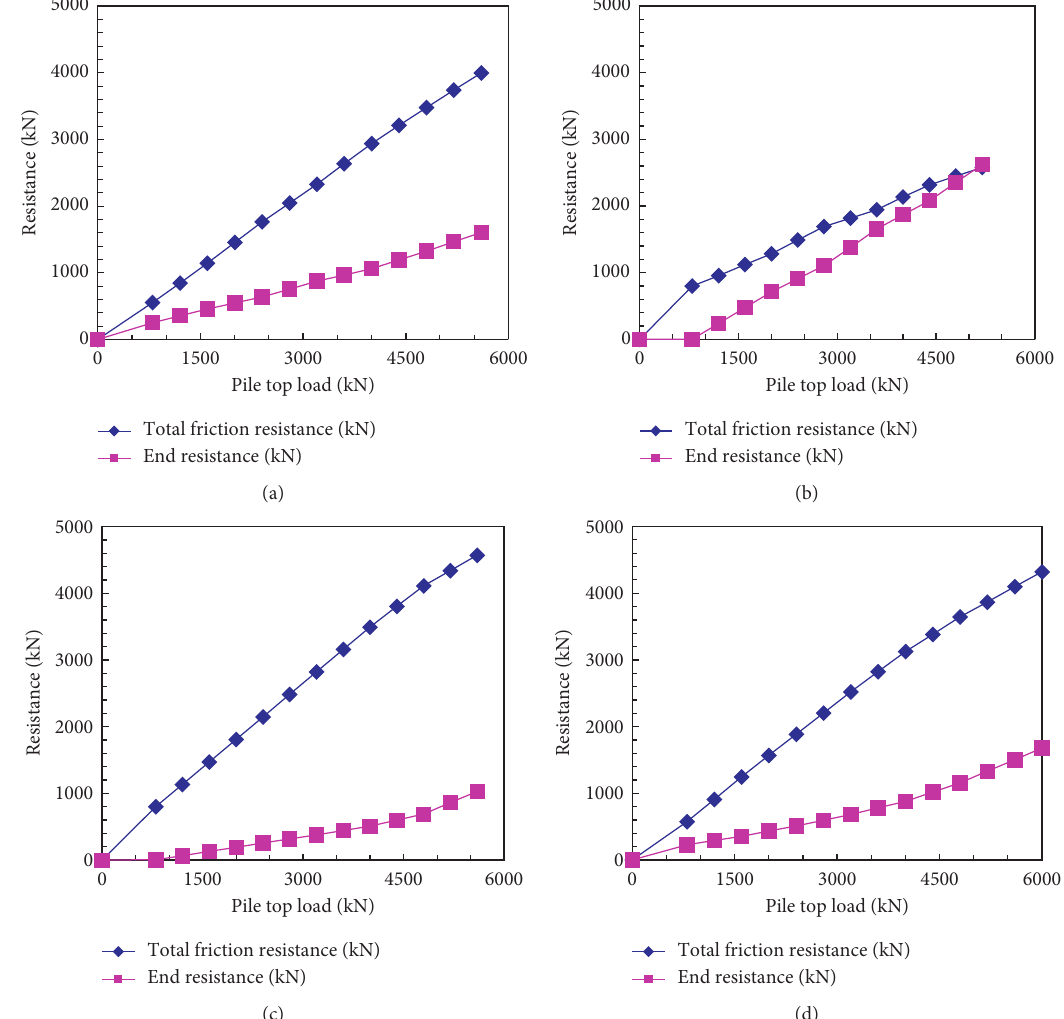
Figure 11: Illustration of relationships between total friction resistance and end resistance under various loads (at the soft rock bearing stratum site). (a) Pile #1. (b) Pile #3. (c) Pile #5. (d) Pile